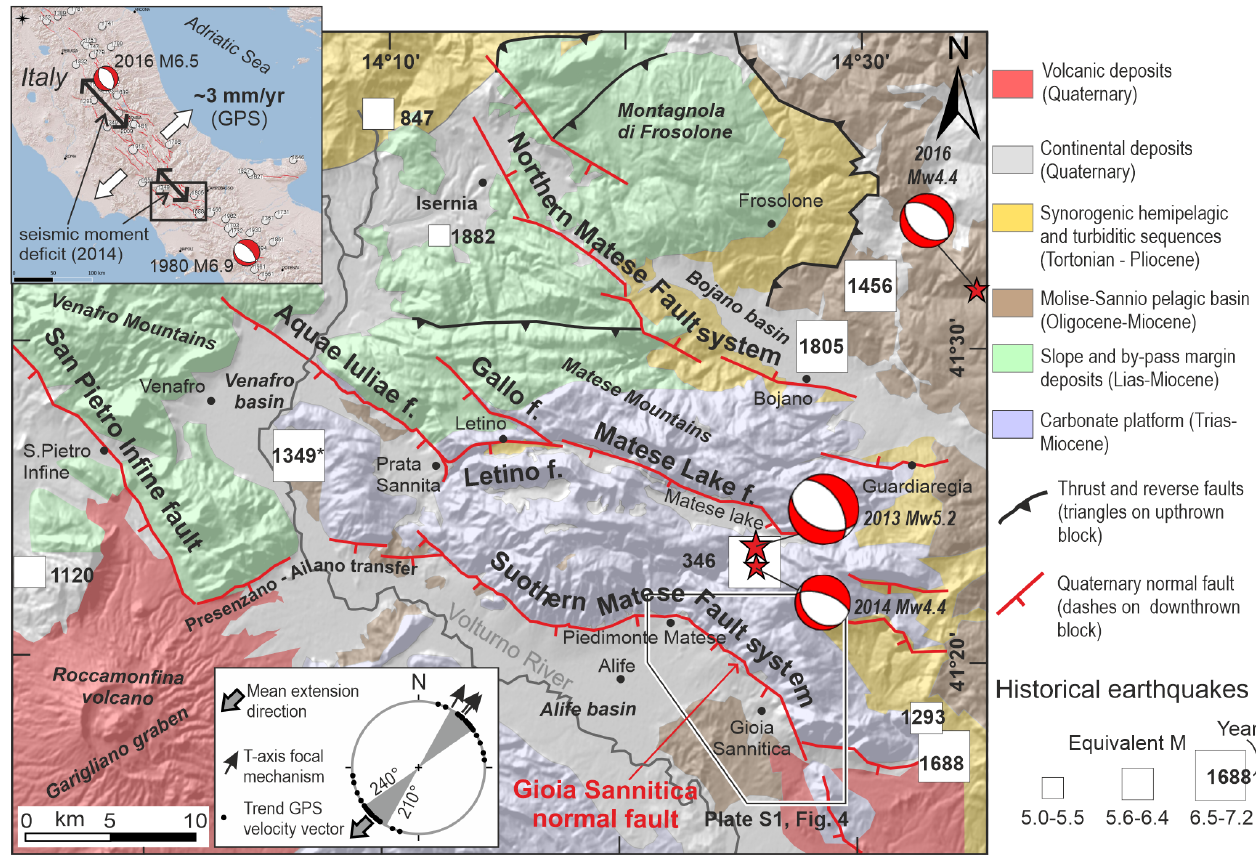
Figure 1. Simplified tectonic map of the Matese area (southern Apennines) showing traces of Quaternary normal faults, epicentres of the largest historical earthquakes (from CPTI15, Rovida et al., 2020; from CFTI5Med for events before 1000CE, Guidoboni et al., 2019; ∗ epicentre from Galli and Naso, 2009), and locations of the southern Matese fault system and Gioia Sannitica normal fault studied in this work. The mean extension direction in the inset is derived from orientations of GPS velocity vectors and T axes of focal mechanisms (modified from Boncio et al., 2016). Focal mechanisms are from the RCMT Catalogue (http://rcmt2.bo.ingv.it/, last access: 30 July 2021). In the inset map, the double arrows parallel to the Apennines indicate areas of seismic moment deficit ( M ≥ 6.5) compared to tectonic (geodetic) strain accumulated in the last 500 years according to D’Agostino (2014); focal mechanisms refer to M ≥ 6.5 instrumental earthquakes, and circles are historical earthquakes with M ≥ 6.0